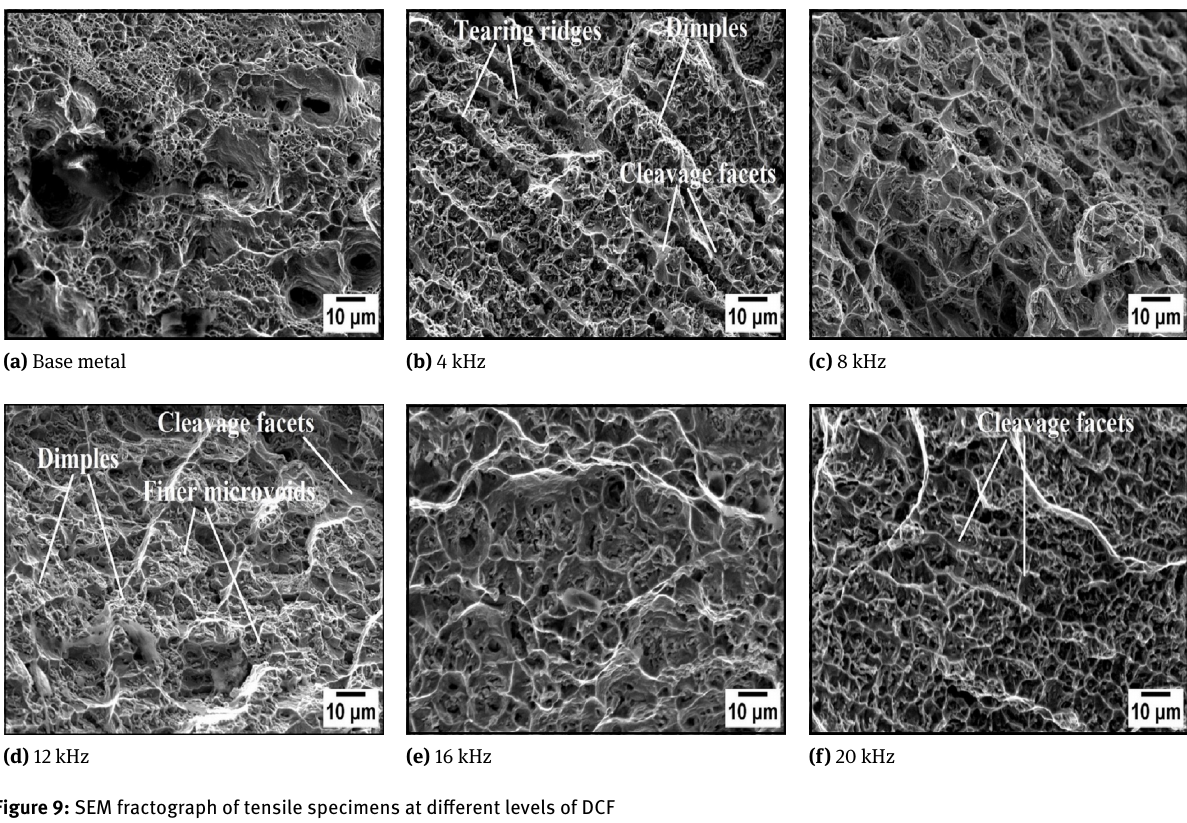
Figure 9: SEM fractograph of tensile specimens at different levels of DCF